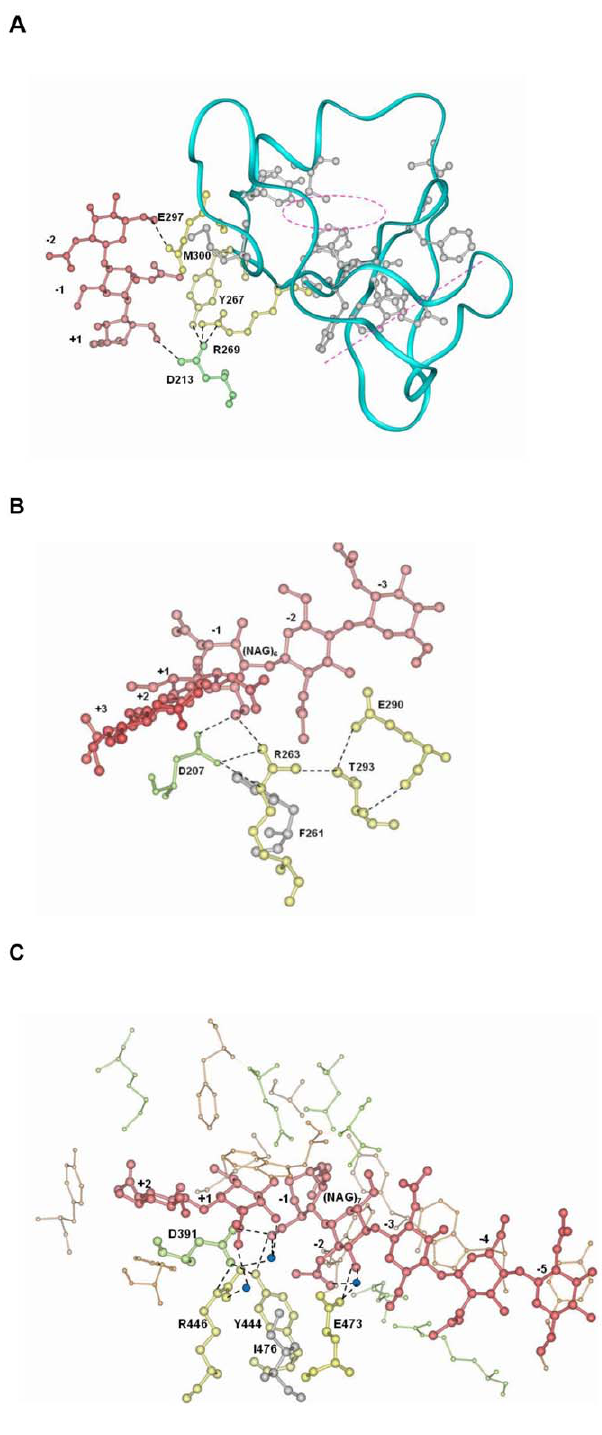
Figure 4. Structures of select family 18 chitinases with their substrates. The TIM barrel residues are coloured in green, the CID residues are in yellow and grey, and substrates are in red. Hydrogen bonds are indicated as dashed lines. (A) The conserved residues on the CID of human chitotriosidase (1HKM) either interact with the substrate, or presumably form a hydrophobic core (Table 1). The a -carbon backbone of the CID is depicted as a blue ribbon. Glu297 on the CID forms a hydrogen bond directly with the substrate while Tyr267 and Arg269 on the CID have hydrogen bonding interactions indirectly through Asp213 on the TIM domain with + 1 subsite of the substrate. Tyr267 and Met300 form hydrophobic interactions with the